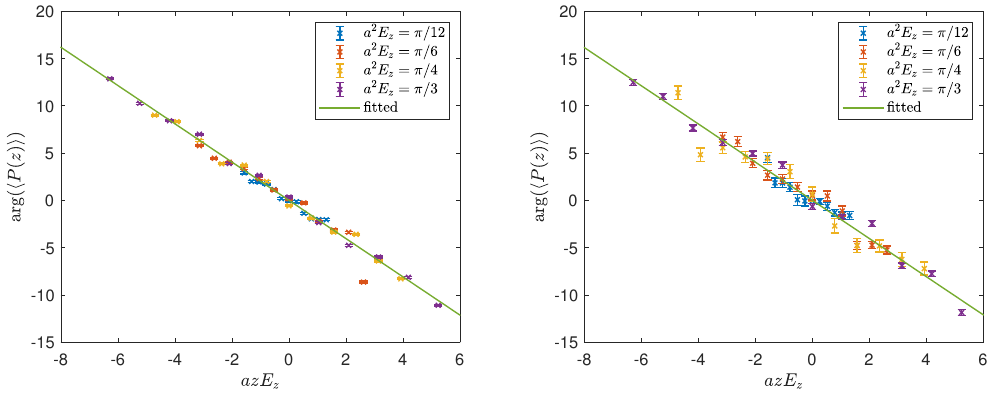
Figure 22 . arg ( h P ( z ) i ) and fitted arg ( h P ( z ) i ) according to the ansatz in eq. (3.11) for β = 5 . 3 (the left panel) and β = 5 . 38 (the right